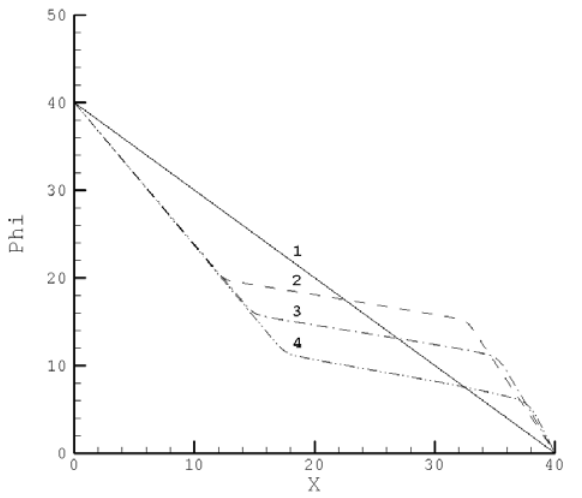
Fig. 5. The potential traveling wave solution of (7) with the initial distribution from (21)-(22); flow velocity u=0.25 . 1: t=0 , 2: t=5 , 3: t=10 , 4: t=15